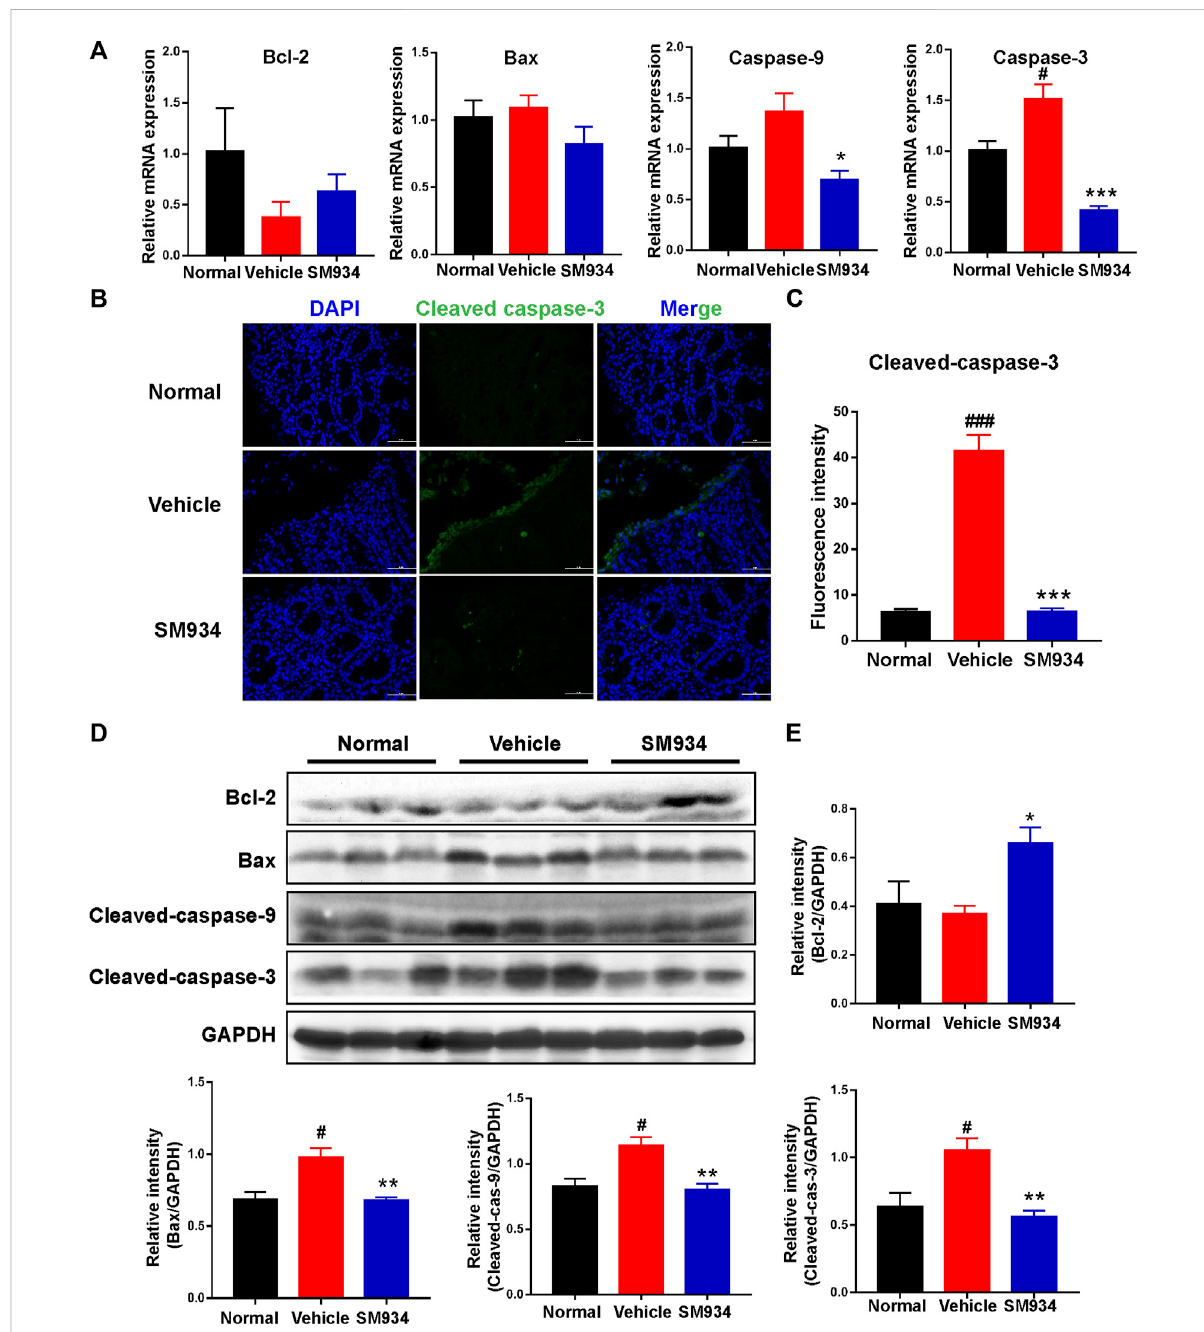
SM934 inhibited apoptosis in TNBS-induced colitis in mice. (A) QPCR analyzed the apoptosis-related gene levels of colon tissues in mice. (B) Representative fl uorescenceimagesofcleavedcaspase-3incolonsections(scalebar,50 µm). (C) Quanti fi cationofcleavedcaspase-3-positivecells incolon tissues. (D) Westernblotting assayed theexpressions ofapoptosis-related proteins of bcl-2, bax, cleaved caspase-9, and cleaved caspase-3 in colon tissue. (E) Relative intensity of proteins to GAPDH. Data are shown as means ± SEM ( n = 3 – 4). # p < 0.05 and ### p < 0.001 vs . normal group; * p < 0.05, ** p < 0.01, and *** p < 0.001 vs . vehicle